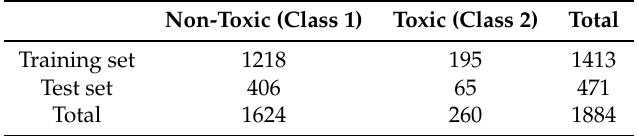
Table 2. Sediment dataset: sample partition in toxic and non-toxic classes.